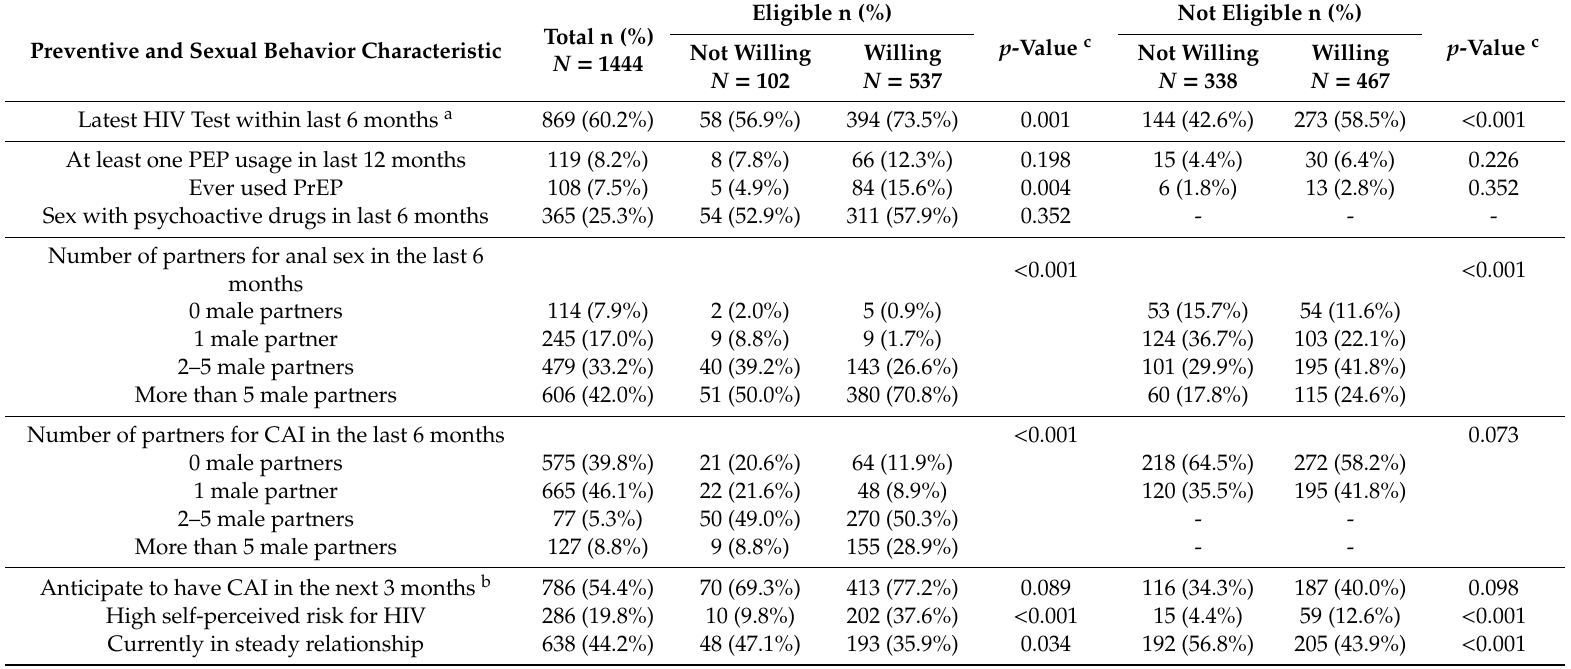
Table 4. Preventive and sexual behavior of